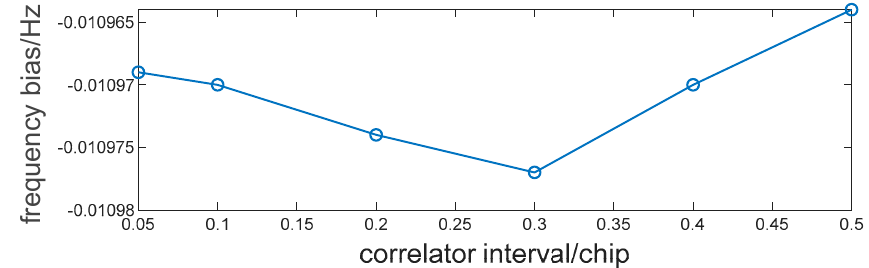
Figure 13. Carrier frequency bias estimation between B2a and B2b of BDS3 prn 21 satellite.